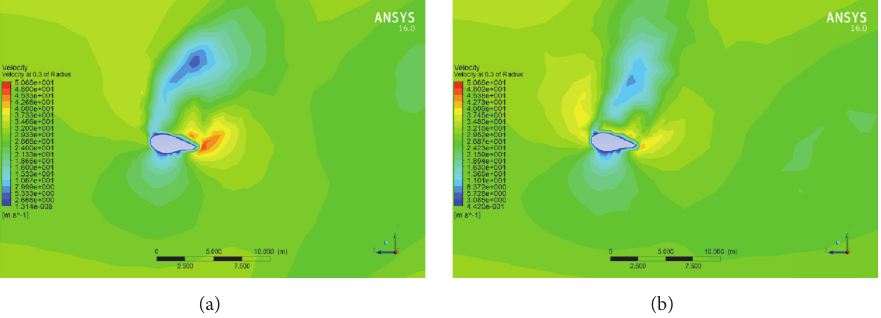
Figure 9: Velocity distribution at 2.5 seconds. Unidirection coupling (a) and bidirectional coupling (b).